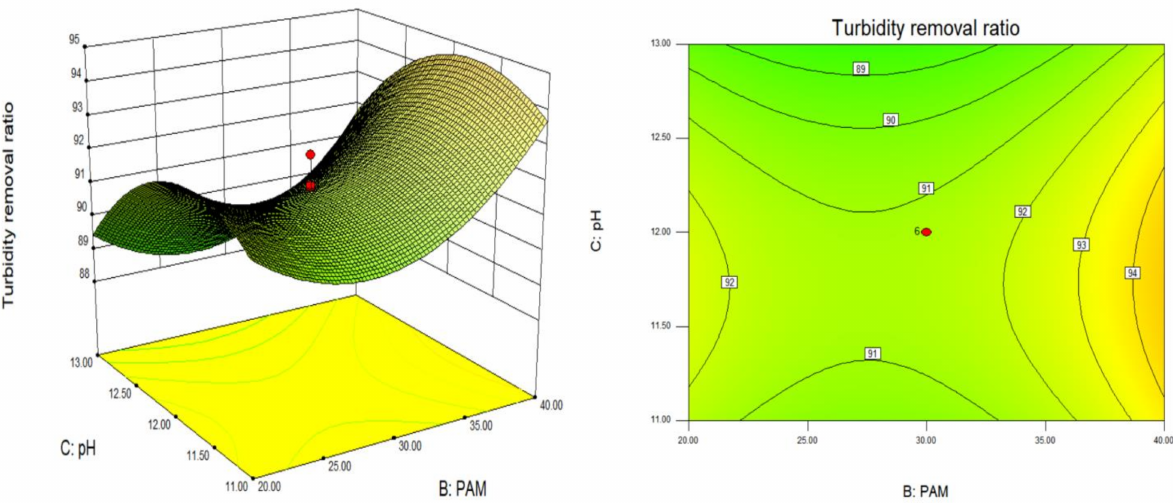
Figure 12. (left) Response surface of the turbidity removal ratio interacted by PAM dosage and pH value. ( right ) Contour map of the turbidity removal ratio interacted by PAM dosage and pH